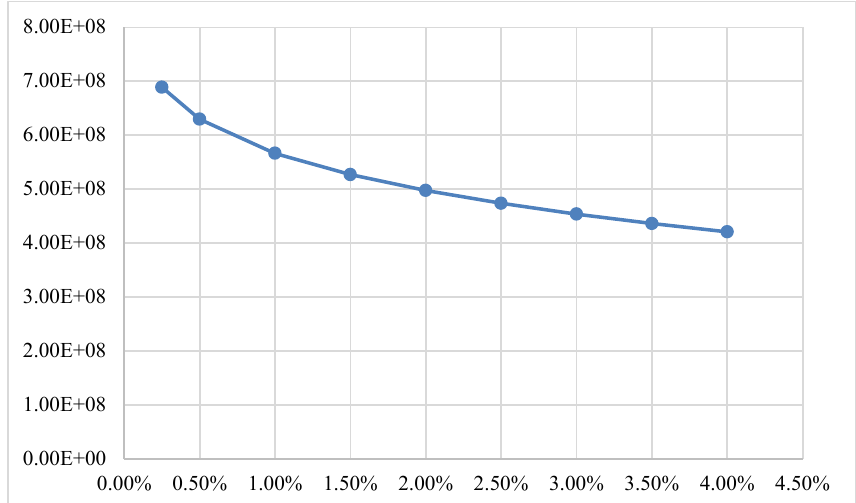
Fig. 1. Graph of CVaR